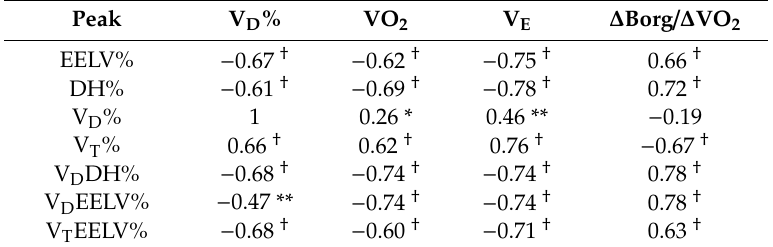
Table 3. Relationships among the compartments of total lung capacity (TLC) and correlations of seven components of total lung capacity (TLC) with oxygen uptake (VO 2 ), minute ventilation (V E ), and dyspnea at peak exercise in 46 patients with